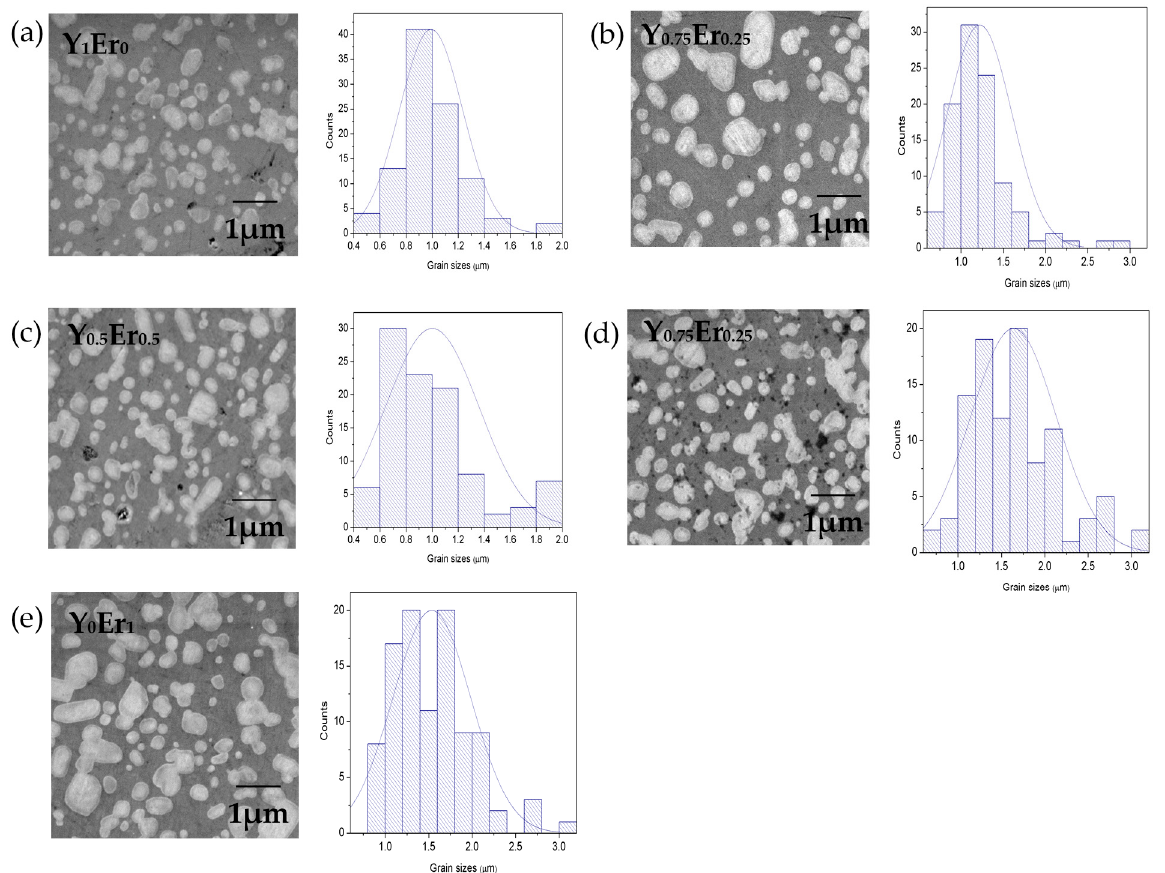
Figure 5. ( a – e ) FESEM images under × 5000 magnifications and distribution of Y211 particle grain size in Y123 matrix. The Y211 particles observed are in spherical shape and fused.